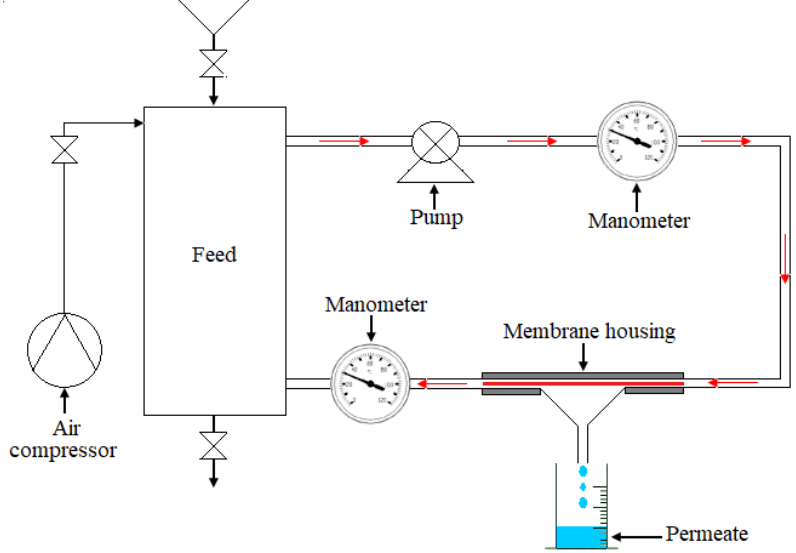
Figure 2. Scheme of the filtration Figure 2. scheme of the filtration pilot.